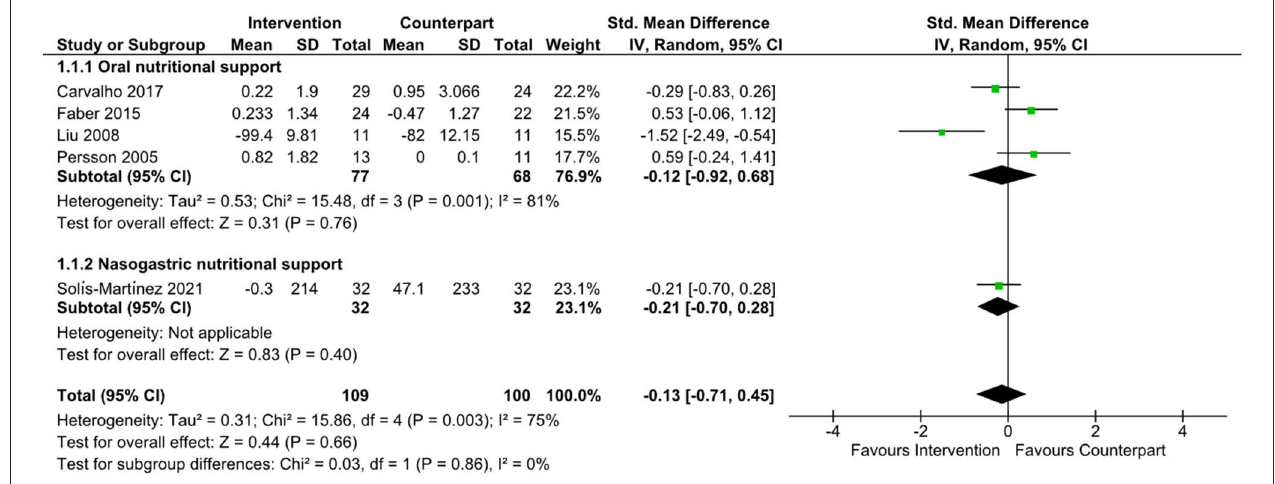
FIGURE 3 | Forest plot of standard mean difference in interleukin 6 levels.